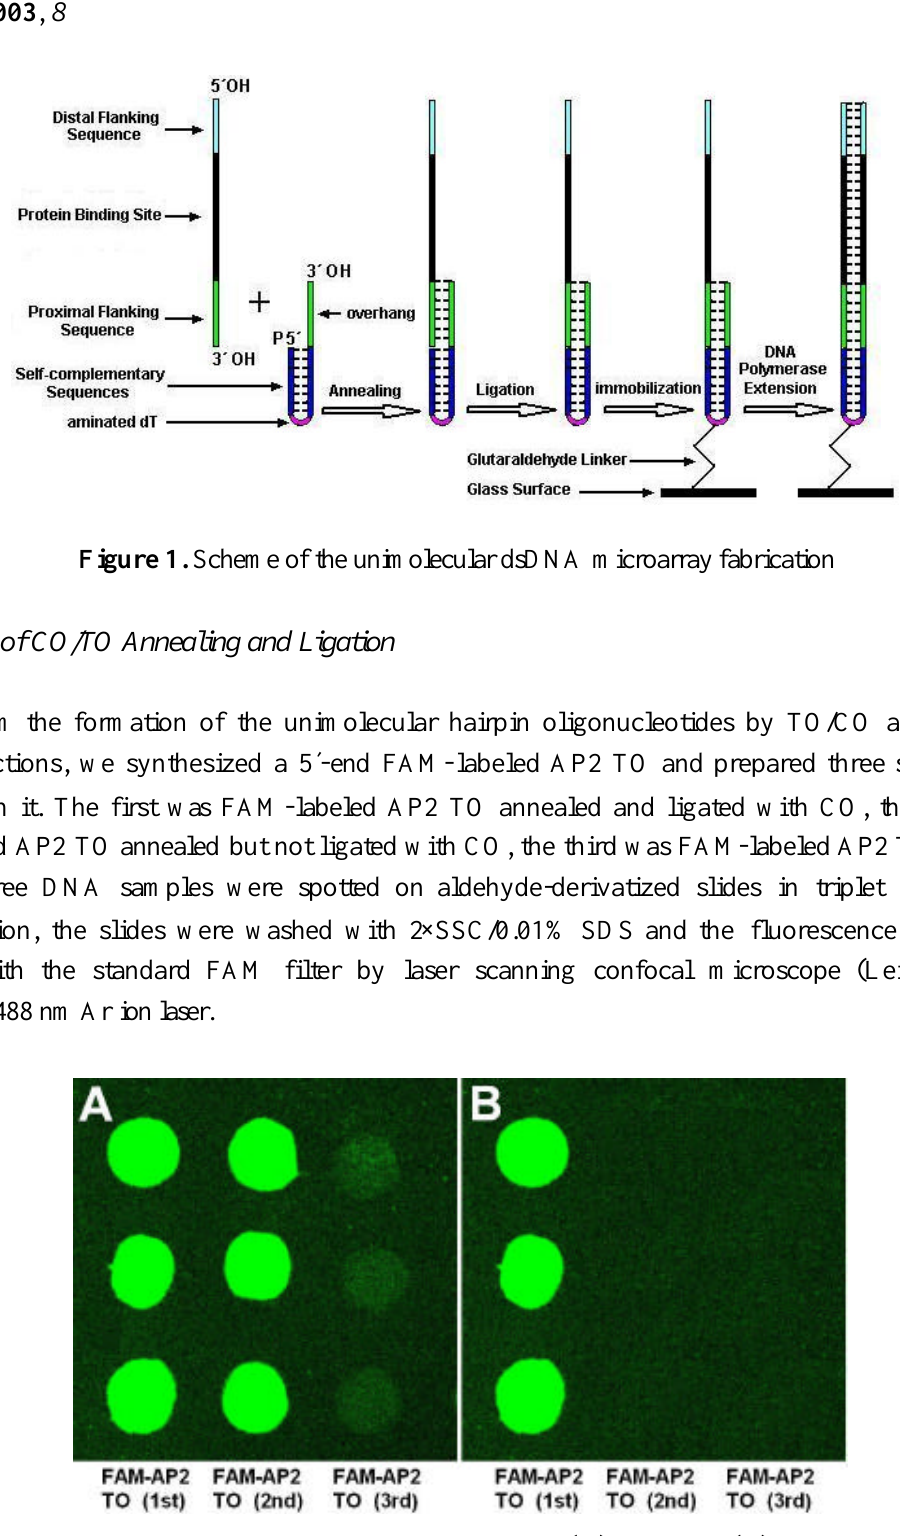
Figure 2. Fluorescence images of AP2 array before (A) and after (B) heat denaturation. FAM-AP2 TO (1st), FAM-AP2 TO (2nd) and FAM-AP2 TO (3rd) referred to FAM-labeled AP2 TO hybridized and ligated with CO, FAM-labeled AP2 TO hybridized but not ligated with CO, FAM-labeled AP2 TO itself